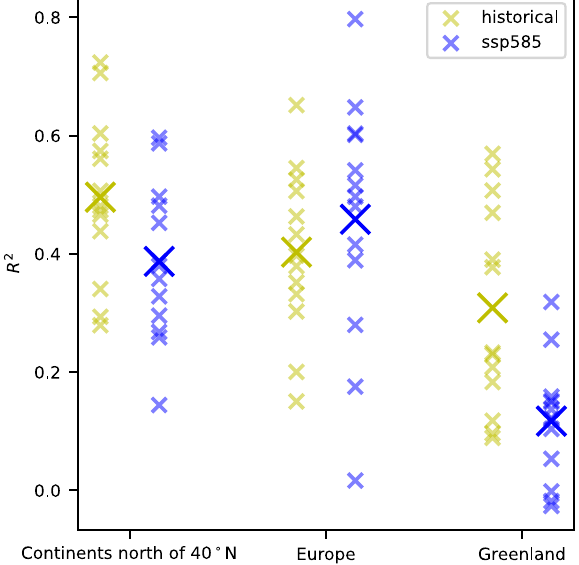
Fig. 6 Ice melting limits temperature variability in future Green- land summer. Time series of daily maximum near-surface tempera- ture (tasmax) at a grid point over Greenland in the ACCESS-CM2 model, for historical (yellow, 1966 – 2005) and SSP585 (blue, 2060 – 2099). The red line marks the ice melting point.